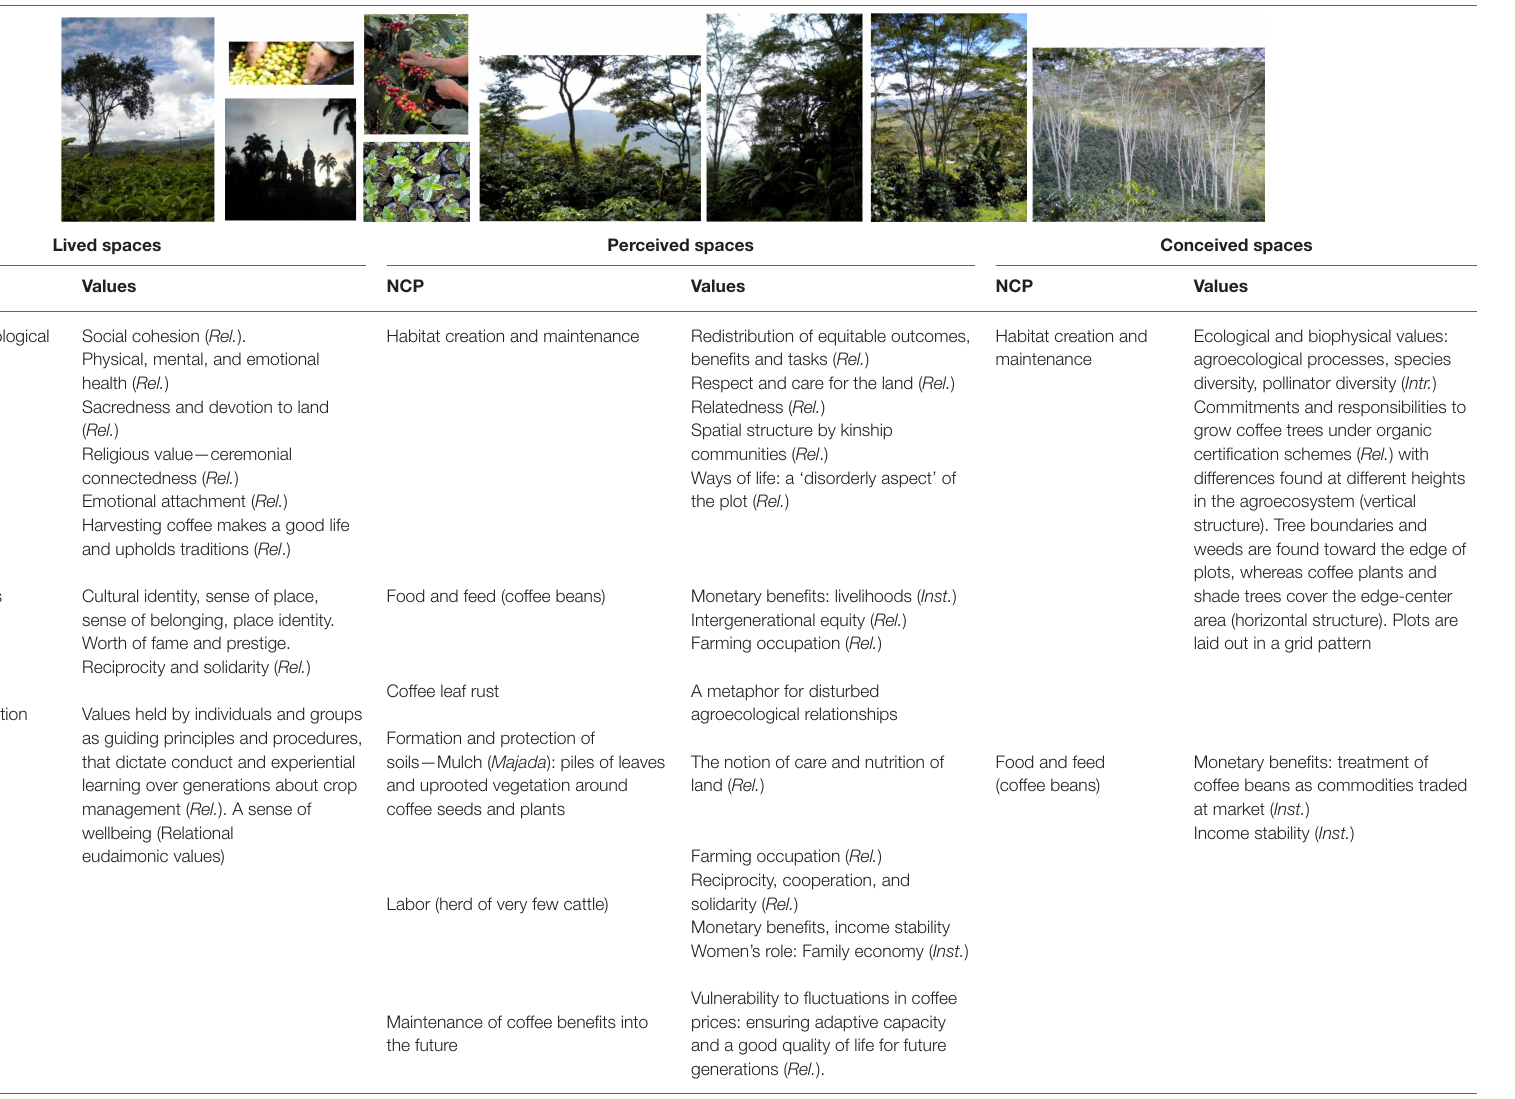
TABLE 1 | Coffee farming ( Coffea arabica L.,